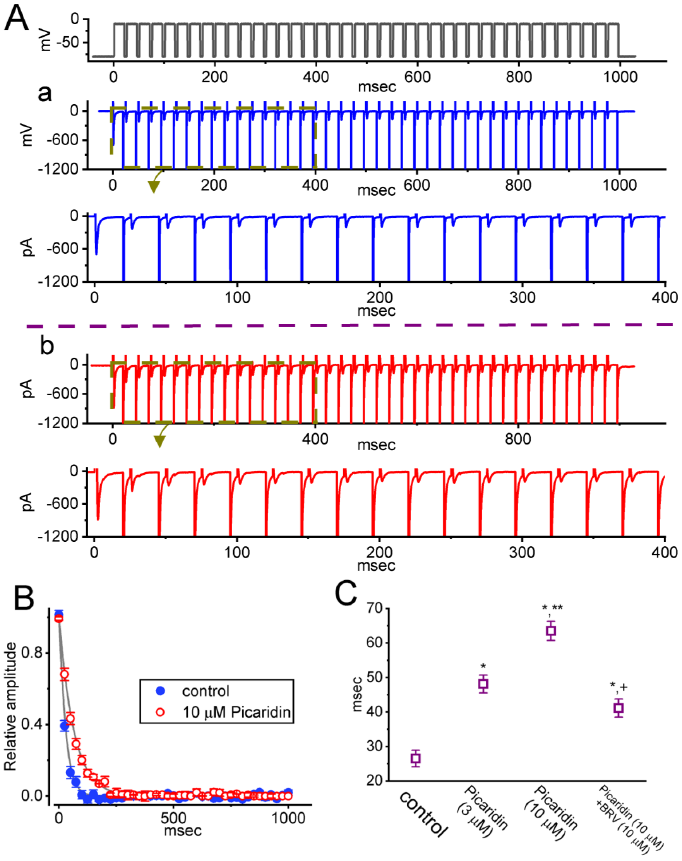
Figure 4. Effect of picaridin on I Na(T) activated by a train of depolarizing pulses in GH 3 cells. The voltage protocol employed consisted of 40 20-ms pulses (stepped to − 10 mV) separated by 5 ms intervals at −80 mV for a total duration of 1 s. ( A ) Representative current traces taken during either the control period ( a , absence of picaridin) or cell exposure to 10 μM picaridin ( b ). The voltage-clamp protocol delivered is illustrated atop the current traces. To provide single I Na trace, the lower side in panels ( a , b ) denotes the expanded record from the brown broken box (with curve arrows) of the upper side in each panel. ( B ) The relationship of I Na(T) versus the pulse train duration in the absence (blue filled circles) and presence (red open circles) of 10 μM picaridin (mean ± SEM; n = 7 for each point). The gray continuous lines on which the data points are overlaid was accurately fitted by a single exponential. Note that with cell exposure to picaridin, the time course of I Na(T) inactivation during a train of depolarizing pulses slowed, together with an increase in time constant of the current inactivation. ( C ) Summary graph demonstrating the effect of picaridin (3 or 10 mM) and picaridin plus ranolazine (Ran) on the time constant of current decay in response to a train of depolarizing command voltage from −80 to −10 mV (mean ± SEM; n = 7 for each point). Current amplitude was measured at the beginning of each depolarizing pulse during depolarizing stimuli. * Signficantly different from control ( p < 0.05), ** Significantly different from picaridin (3 μM) alone group ( p < 0.05), and + Significantly different from picaridin (10 μM) alone group ( p < 0.05).